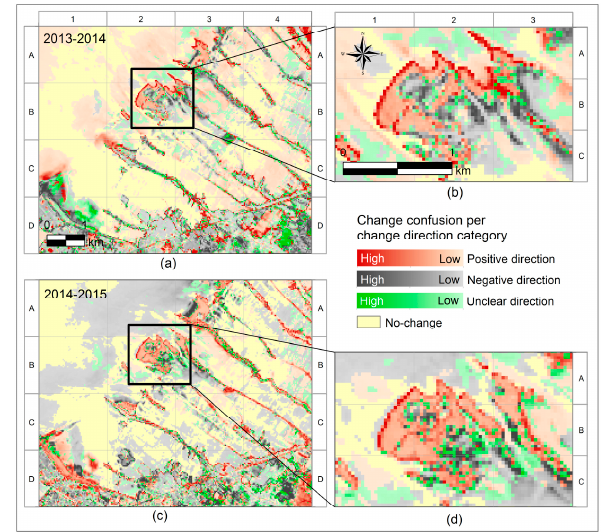
Figure 8. Total intensity of confusion indices for each change direction category: in the period 2013–2014 ( a , b ); and in the period 2014–2015 ( c , d ). Shades of orange pixels represent change confusion values for the area with positive direction , and shades of grey pixels show change confusion values for the area with negative direction . The change confusion values for the unclear direction category are represented by shades of green, whereas no-change category is depicted by light yellow color.